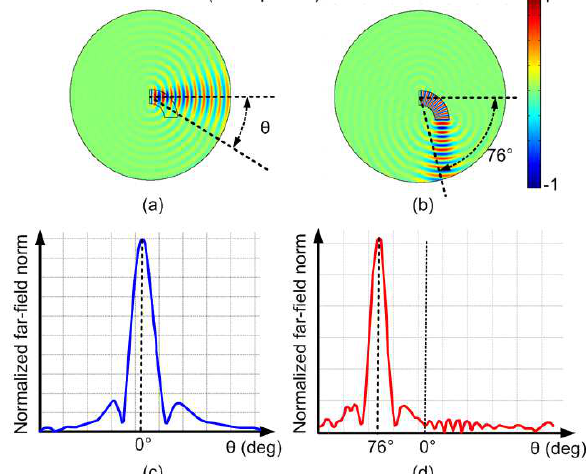
Figure 7: (a)-(b) Calculated emission of a plane current source above a limited metallic ground plane without and with the metamaterial structure. (c)-(d) Calculated normalized far field of the antenna without and with metamaterial. A 76° rotation of the radiation is clearly observed.